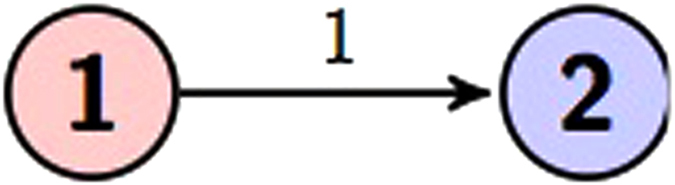
Two qudit graph.